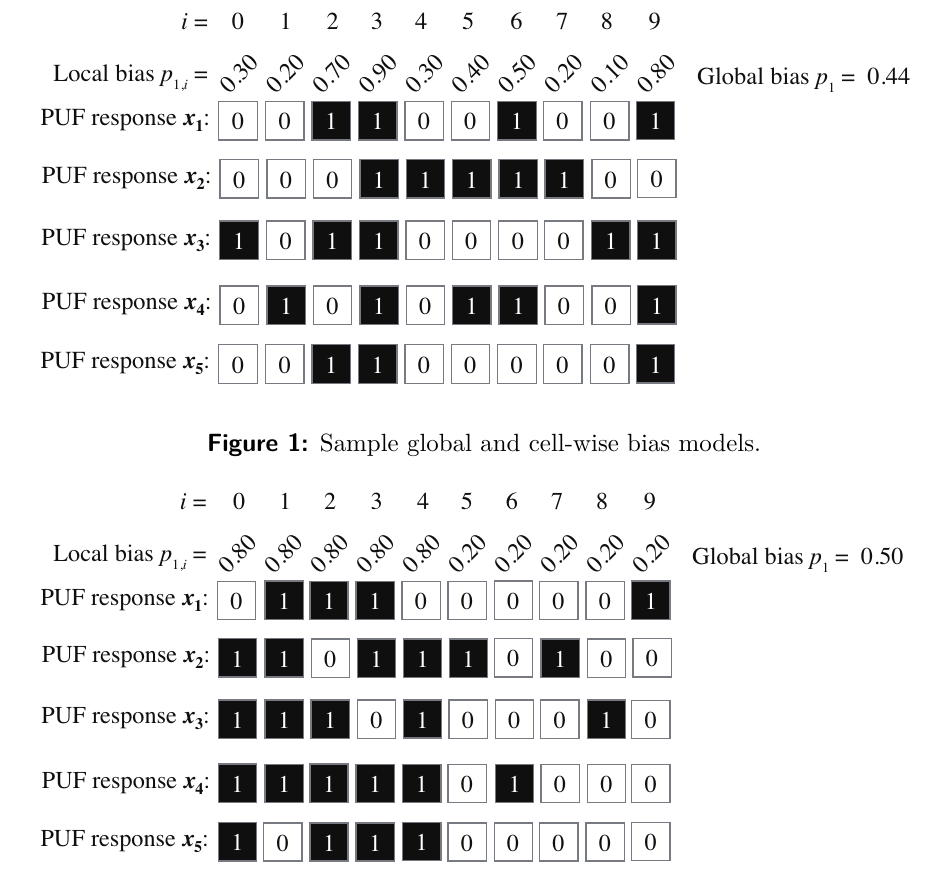
Figure 2: Example of PUF response with typical cell-wise bias, where there are two areas with different